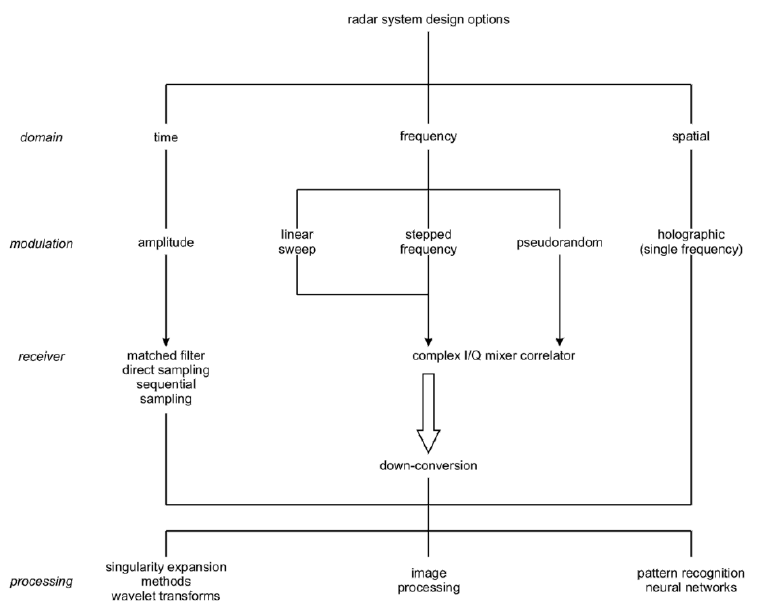
Figure 1. Classification of main types of subsurface radar [2].